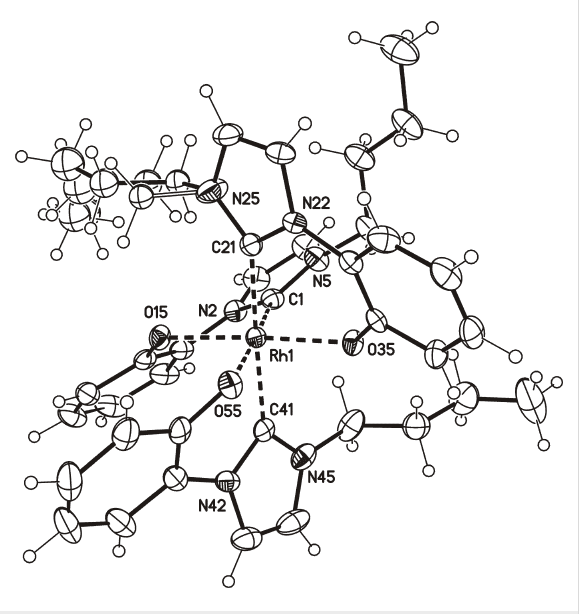
Figure 4: Molecular drawing of rhodium complex 11 (minor disorder parts omitted for clarity, displacement parameters are drawn at 50% probability level; crystallographic